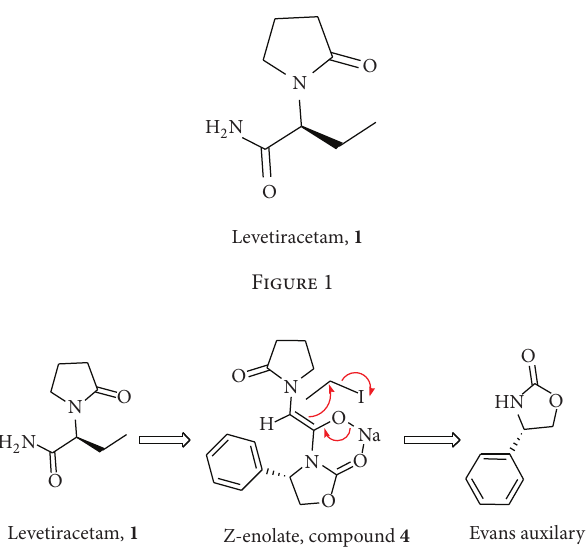
F 2: Retrosynthetic analysis of (